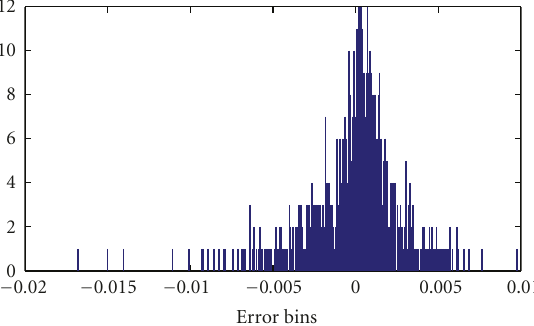
Figure 7: Histogram plot of the errors obtained for an epoch.